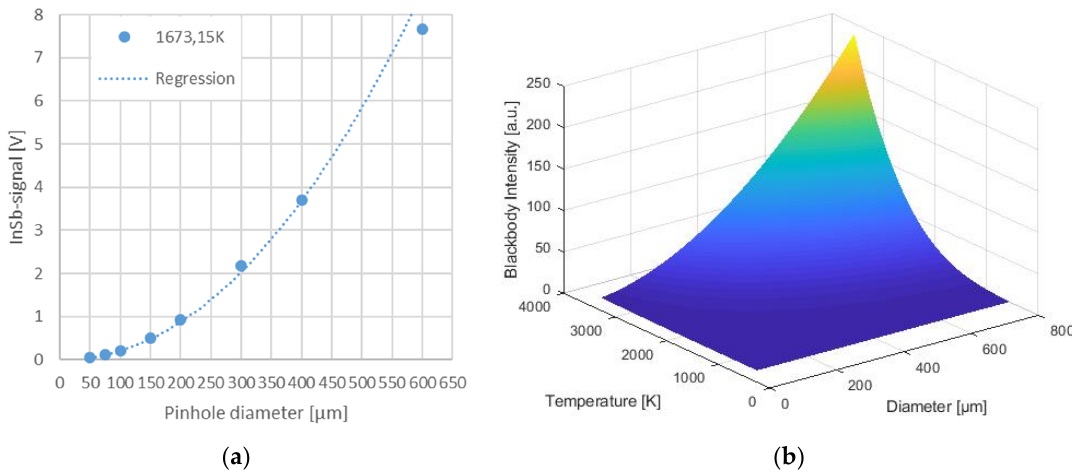
Figure 4. This figure shows the measured blackbody reference data fitted by an exponential function exemplary for 1400 K ( a ) and an extended 3d surface ( b ) calculated from all reference data for all diameters between 50 µm and 800 µm and temperatures between 300 K and 3500